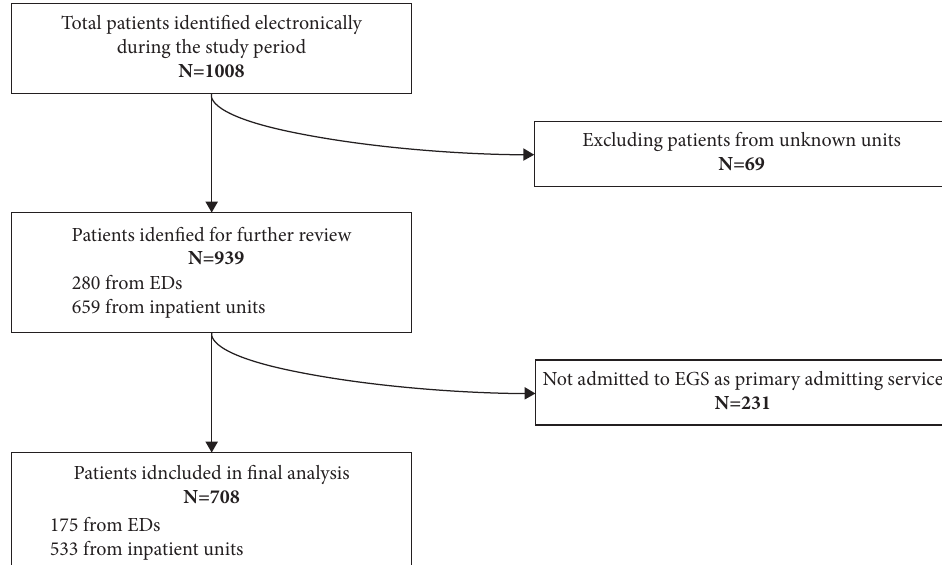
Figure 1: Patient selection diagram mapping out patients who were transferred for EGS and included in the final analysis. ED: emergency department; EGS: emergency general